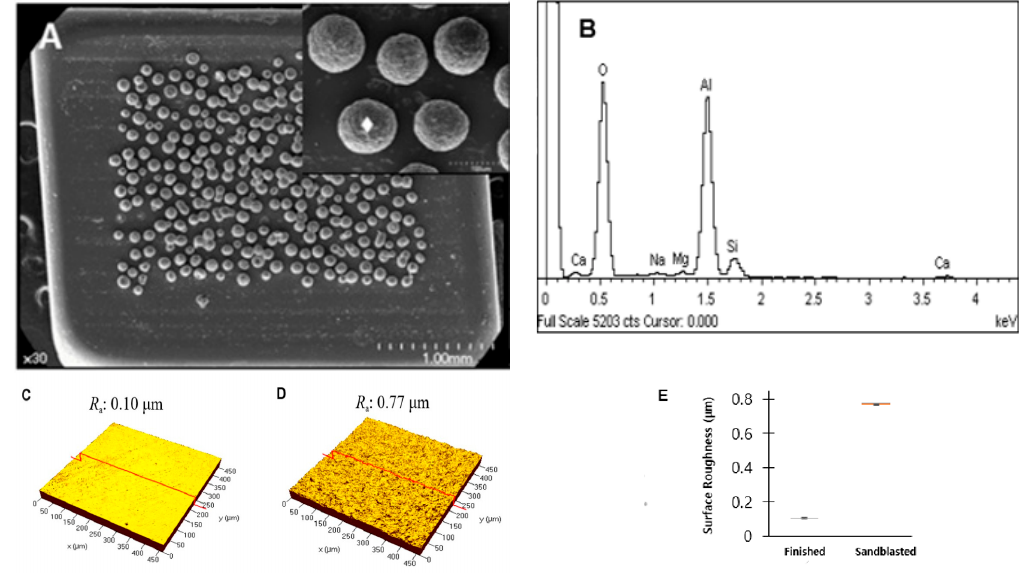
Figure 2. SEM images, EDS analysis and roughness. ( A ) SEM images of the bracket base at × 30 and × 300. ( B ) EDS analysis of the spherical retentive microstructures (white diamond in A). ( C ) CLSM images of the zirconia surface before (median surface roughness (R a ): 0.104 µ m) and ( D ) after the sandblasting (median surface roughness (R a ): 0.773 µ m). Sandblasted surface ( D ) showed evenly distributed microroughness. ( E ) Surface roughness (R a ) before and after